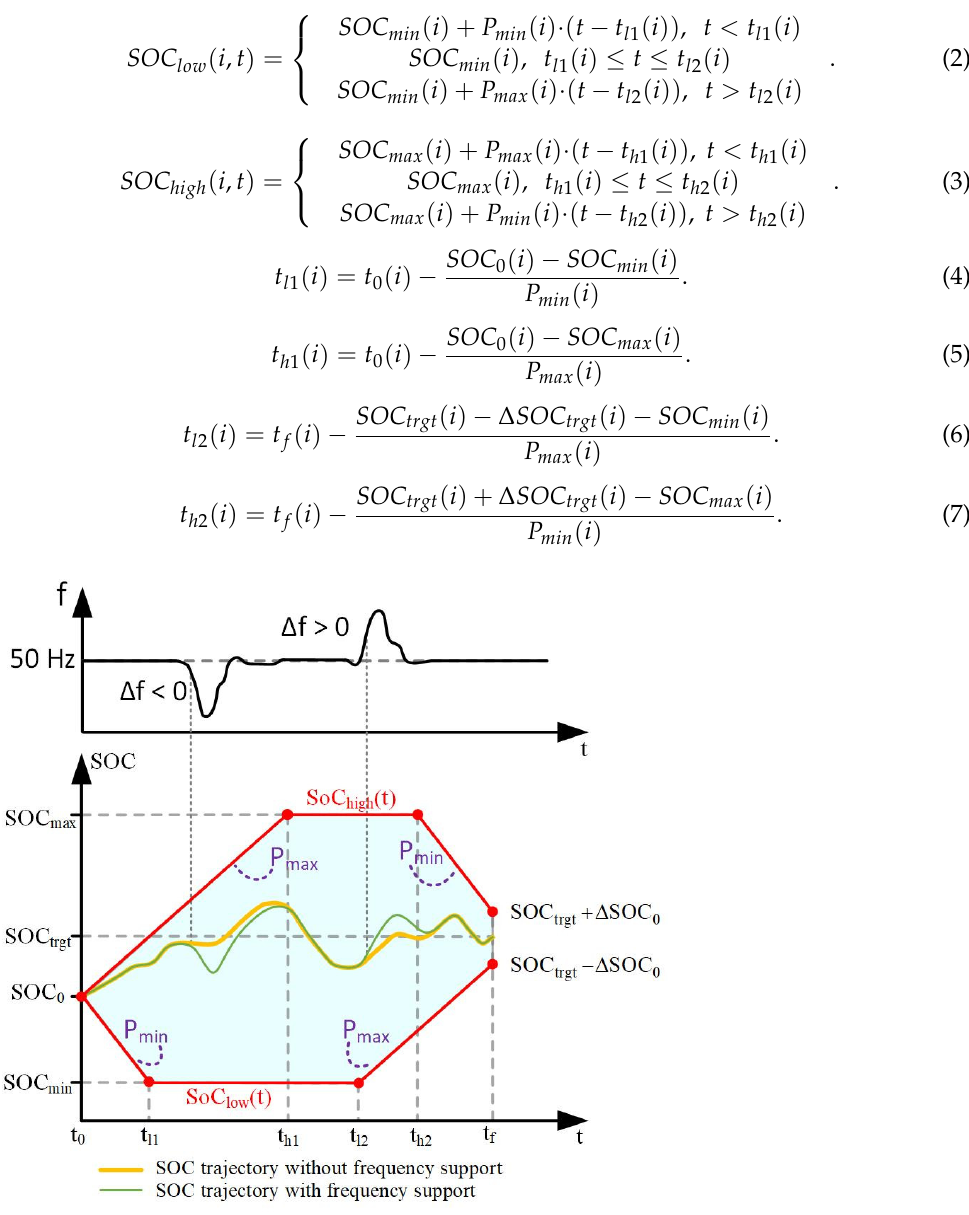
and dis- (cid:2868)